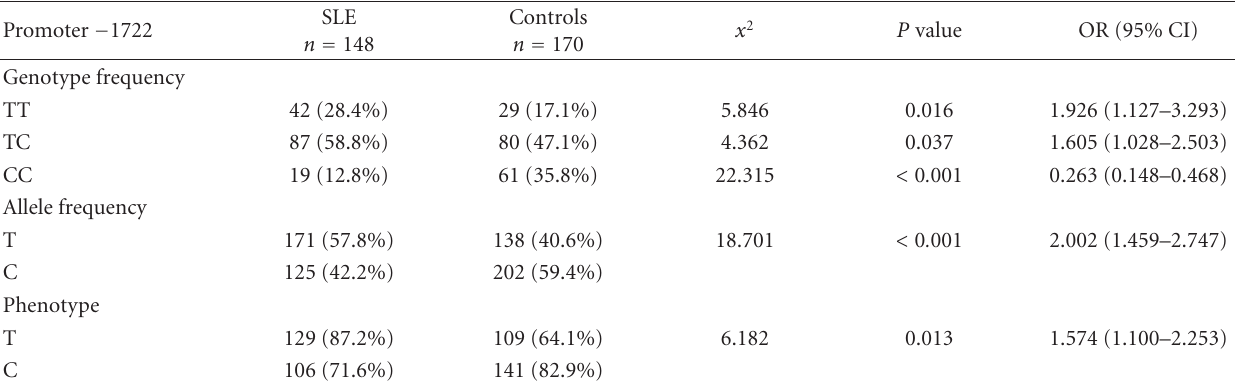
Table 1: Genotypic distribution and allelic frequencies of − 1722 CTLA-4 polymorphisms in Chinese SLE patients and healthy controls.